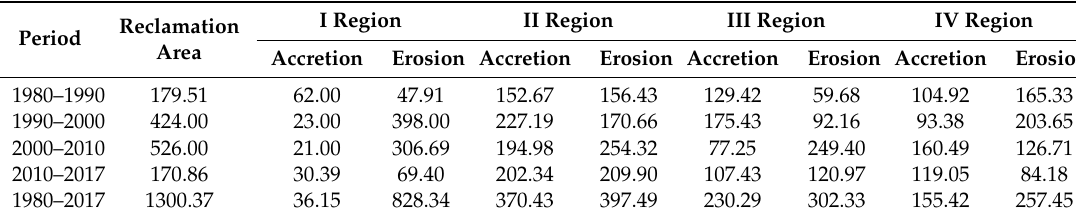
Table 1. Area change at di ff erent periods during 1980–2017 in the study area (unit: km 2 ). Reclamation Period